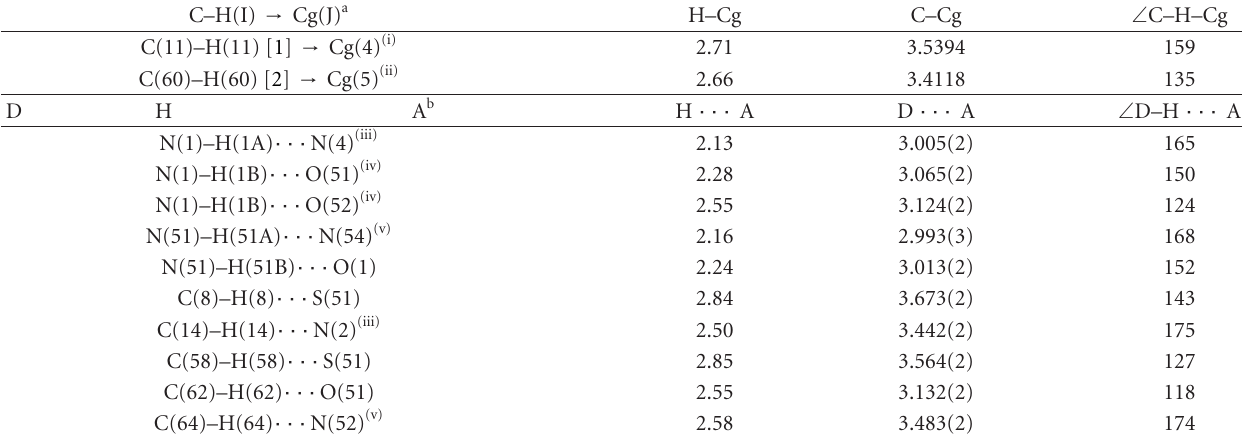
Figure 2: Arrangement of the intermolecular hydrogen bonds in 5 . Table 3: C–H → π interactions and intermolecular hydrogen bonds for